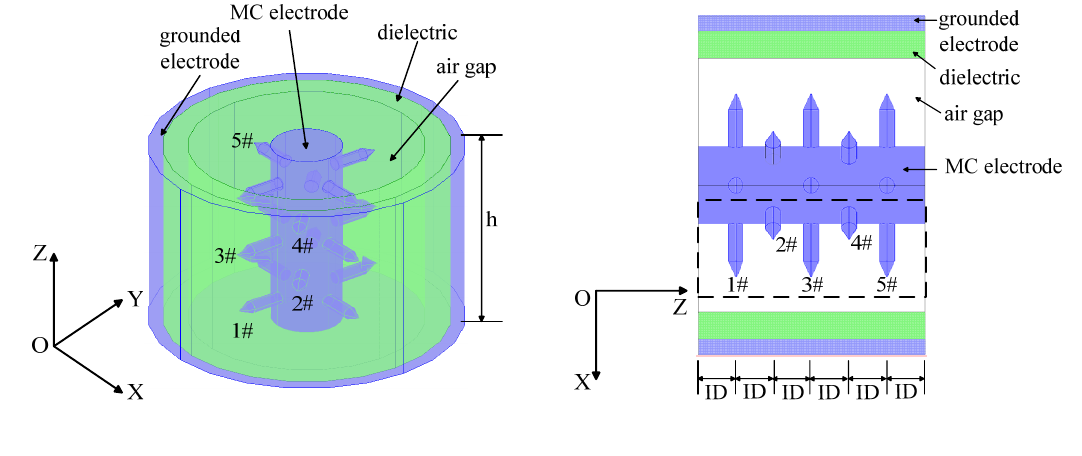
Figure 6. Simulation geometry model (the domain in the dashed frame is the one given of E1, E2, E5 and E6 in Figures 8 and 9).